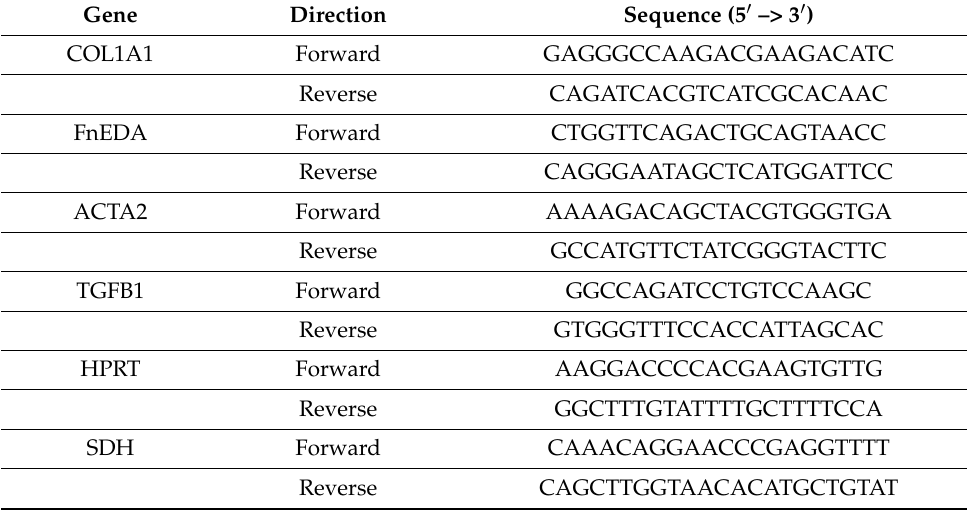
Table 1. Oligonucleotides used in real-time